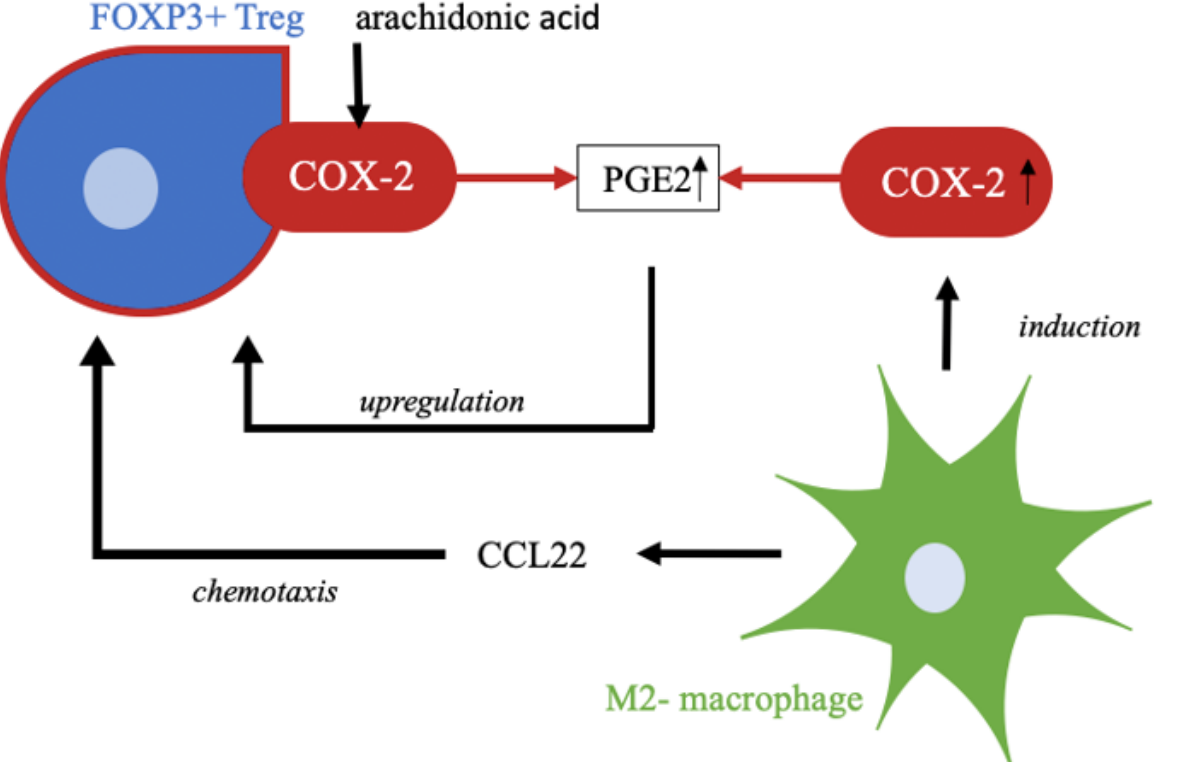
Figure 5. COX-2 produces PGE2, a prostaglandin, from the substrate arachidonic acid as part of lipid metabolism. Upregulation of Treg cells is affected by this prostaglandin. M2-polarized macrophages attract regulatory T cells by chemotaxis, e.g., by CCL22. In addition, M2-polarzied macrophages induce expression of COX-2, which in turn leads to higher enzyme activity and thus higher accumulation of products, such as PGE2 [27,28,48,54,55].